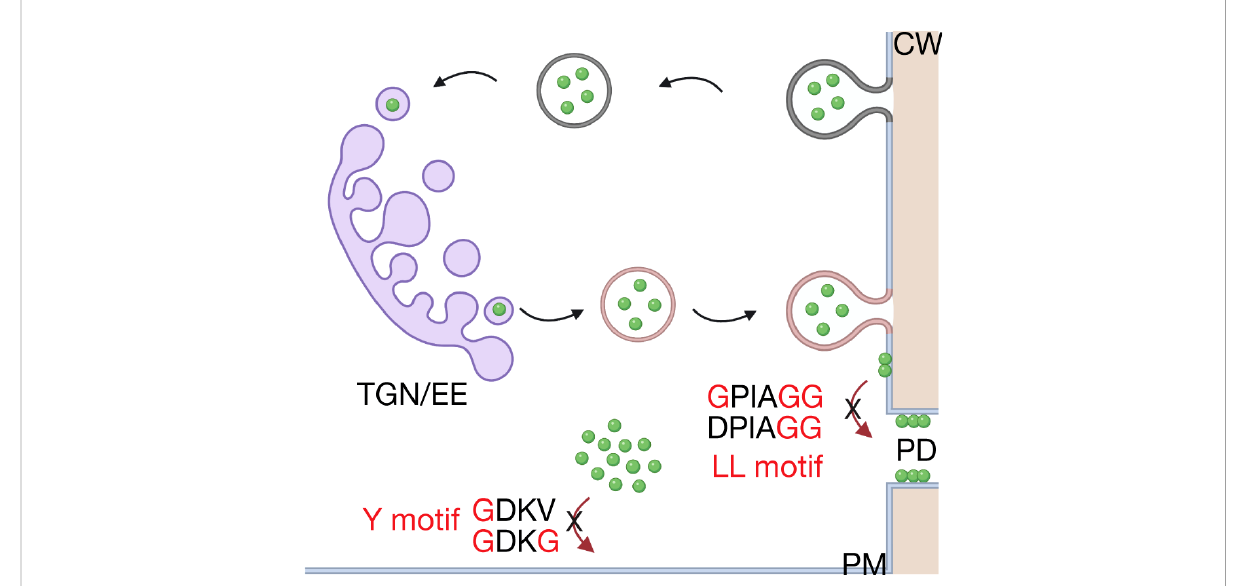
FIGURE 7 Working model for intracellular traf fi cking of OuMV MP. The MP (green) is targeted to the plasma membrane via an unknown mechanism. It is retrieved from the plasma membrane (dark gray) and transported to the TGN (purple). From the TGN, the MP is recycled back to the plasma membrane (pink). The Y motif possibly acts as a structural motif rather than a functional internalization motif, whereas the LL motif is required for correct plasmodesmata targeting of MP. TGN/EE, trans-Golgi network/early endosome; PM, plasma membrane; PD, plasmodesmata; CW, cell wall. The model was created with